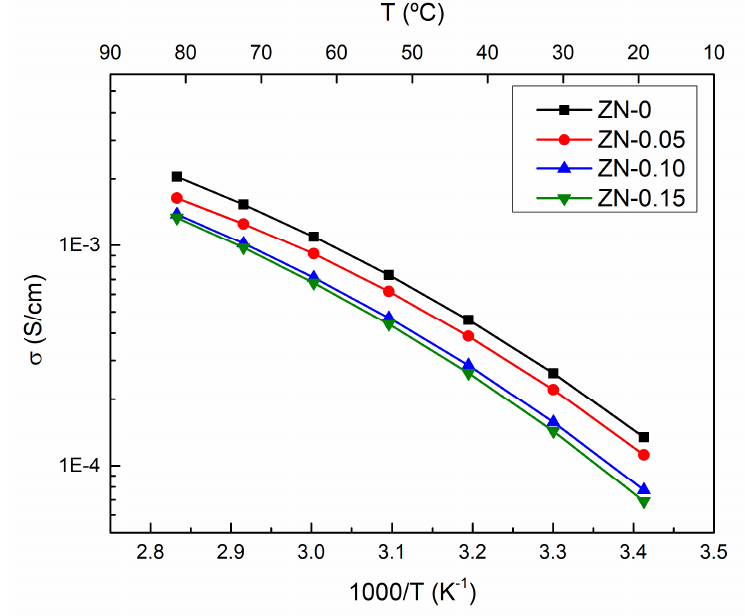
Figure 4. Arrhenius plots of ionic conductivity of LiTFSI/poly(ethylene glycol)dimethyl ether (PEGDM) mixtures with ( ZN ‐ 0.05, 0.10 and 0.15) and without ( ZN ‐ 0) ZN zwitterion measured